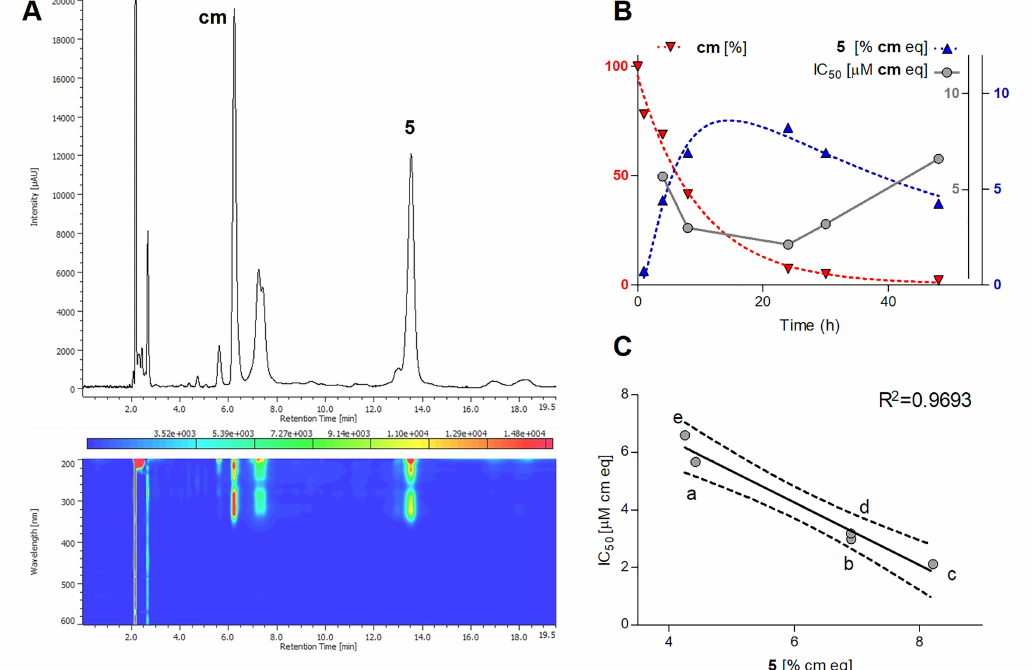
Figure 3. Results of the longitudinal study on the reaction between methyl ca ff eate ( cm ) and α , α (cid:48) -azodiisobutyramidine dihydrochloride (AAPH). ( A ) Supercritical fluid chromatography- photodiode array (SFC-PDA) fingerprint of the most potent cytotoxic sample taken at 24 h of reaction time; chromatogram represents maximum absorbance in the wavelength range of λ = 350–600 nm. ( B ) Time dependency of the reaction and the IC 50 values of the respective samples taken at 0 h (t 0 ), 1 h (a), 4 h (b), 8 h (c), 24 h (d), 30 h (e), and 48 h (f) on HeLa cells. Amounts of compound 5 (right y-axis, blue) and IC 50 values (right y-axis, grey) of the samples are expressed in cm equivalents ( µ M and %, respectively), nonlinear regression for the amounts of cm (left y-axis, red) and 5 was performed by the one-phase decay and the log Gaussian models of GraphPad Prism 5.0, respectively. ( C ) Linear correlation between the relative area under the curve (AUC) values of compound 5 and the IC 50 values. The 95% confidence interval of the regression line is shown with dashed lines; AUC is given in % relative to that of cm at t 0